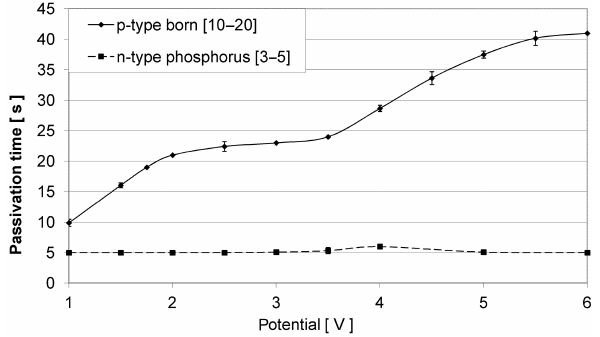
Figure 1. Conductivity type and potential-dependent passivation time at 2s pulse length.